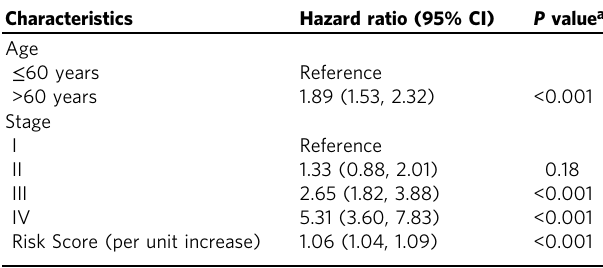
Table 3 Multivariable analysis of risk score for the combined TCGA, ACRG, and Sohn et al.